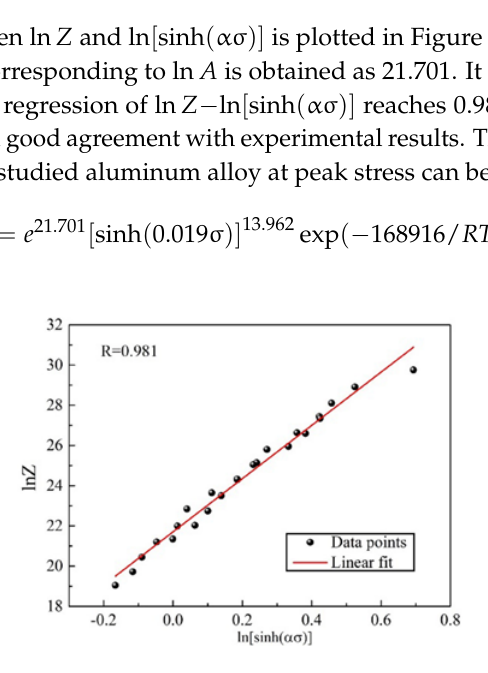
Figure 6. Relationship between flow stress and Zener–Hollomon parameter.